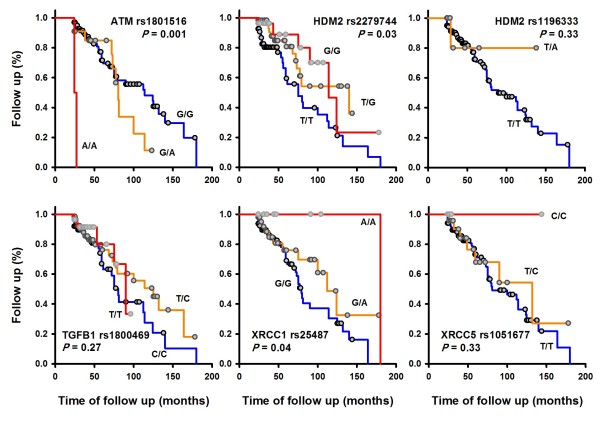
Kaplan-Meier analysis of the relationship between the genotypes of the 6 significantly-associated-SNPs and length of patients’ follow-up following radiotherapy. Symbols represent censored data points.